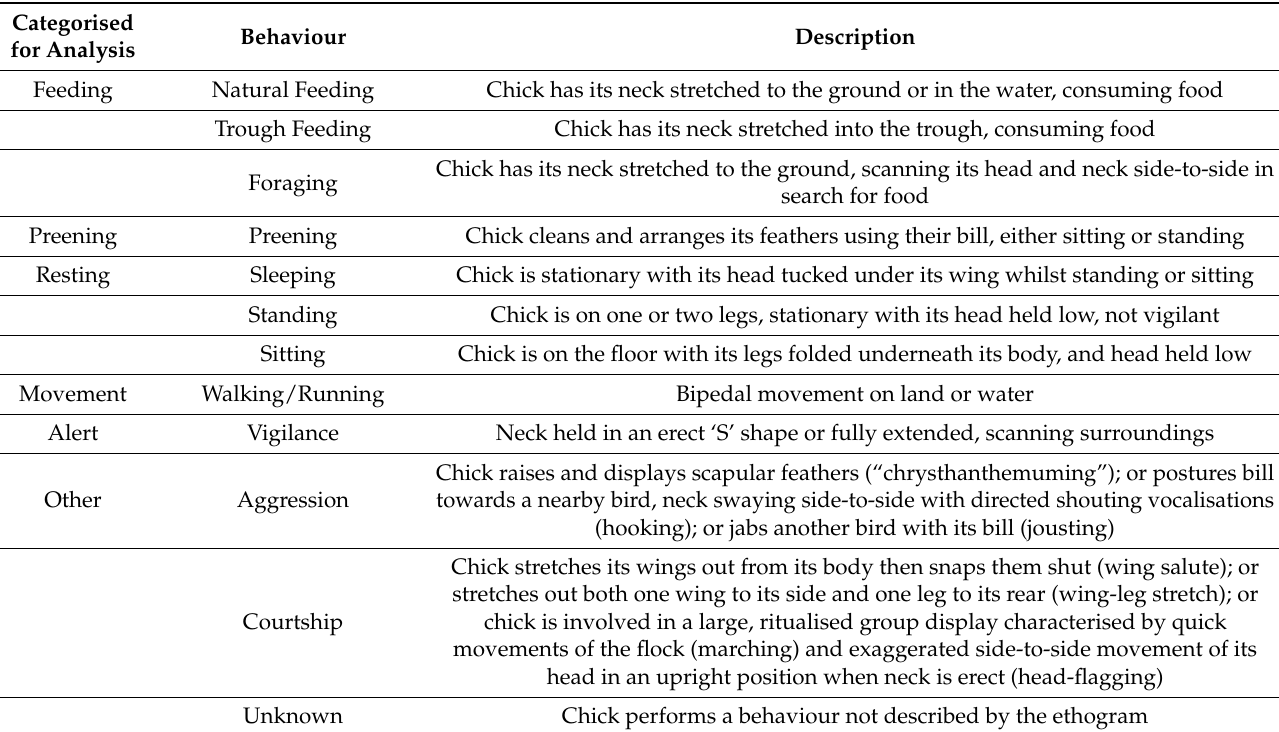
Table 1. Ethogram of Chilean flamingo behavioural states used to identify chick behaviour. Categorised Behaviour Description for Analysis Feeding Natural Feeding Chick has its neck stretched to the ground or in the water, consuming food Trough Feeding Chick has its neck stretched into the trough, consuming food Chick has its neck stretched to the ground, scanning its head and neck side-to-side in Foraging search for food Preening Preening Chick cleans and arranges its feathers using their bill, either sitting or standing Resting Sleeping Chick is stationary with its head tucked under its wing whilst standing or sitting Standing Chick is on one or two legs, stationary with its head held low, not vigilant Sitting Chick is on the floor with its legs folded underneath its body, and head held low Movement Walking/Running Bipedal movement on land or water Alert